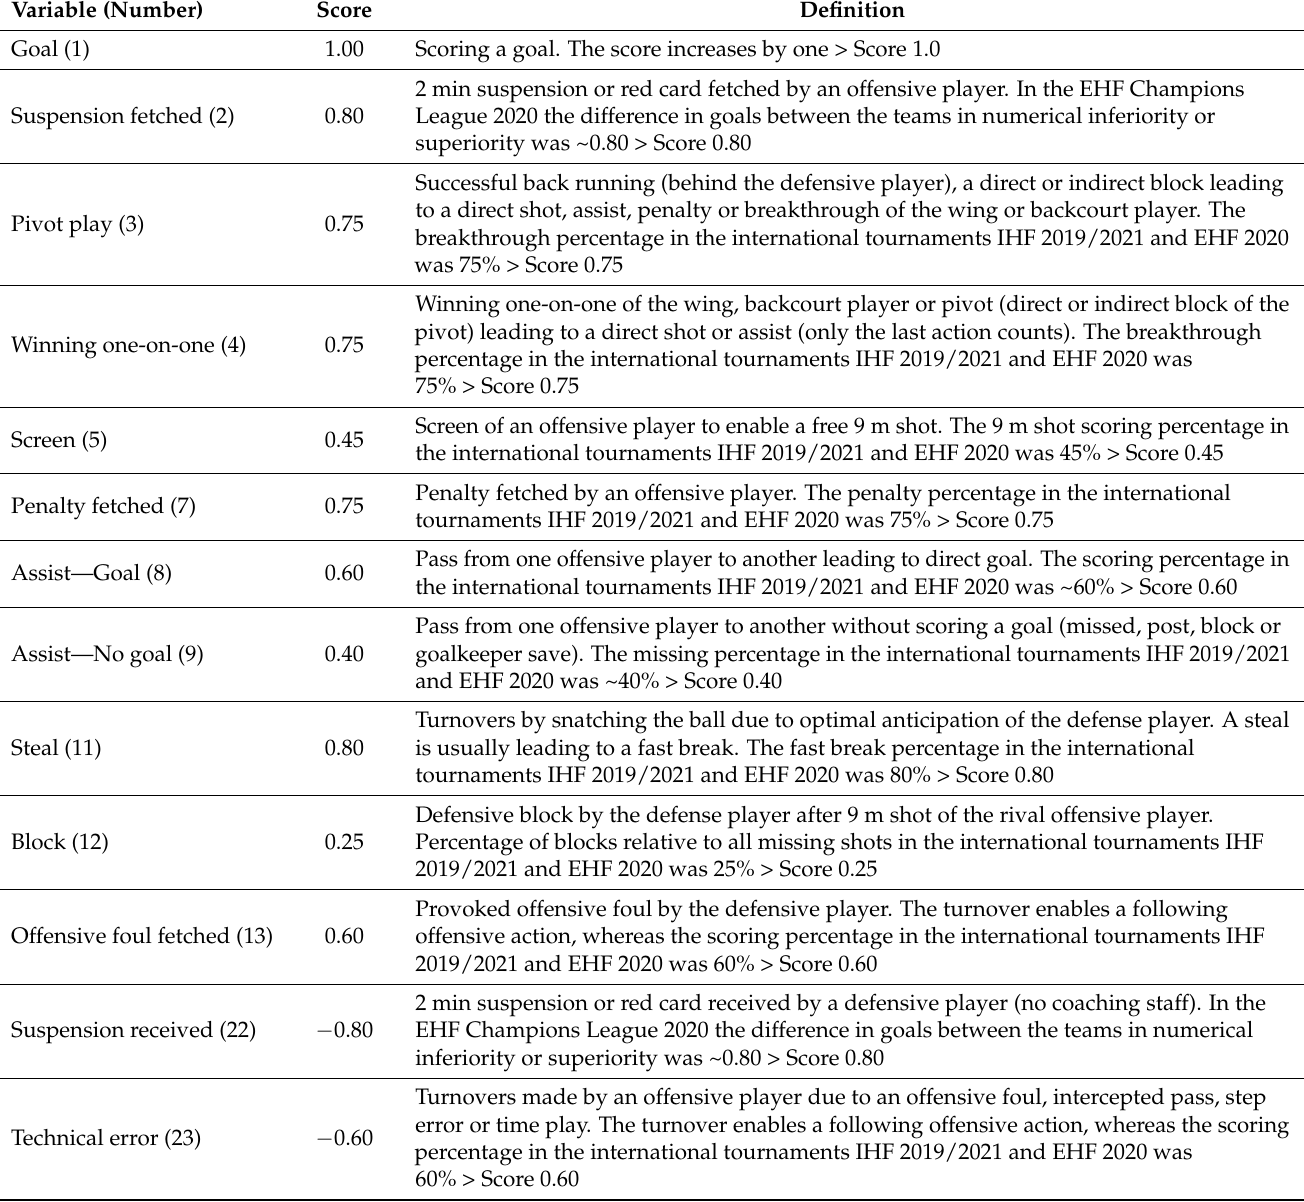
Table 2. Definition of the PlayerScore playing